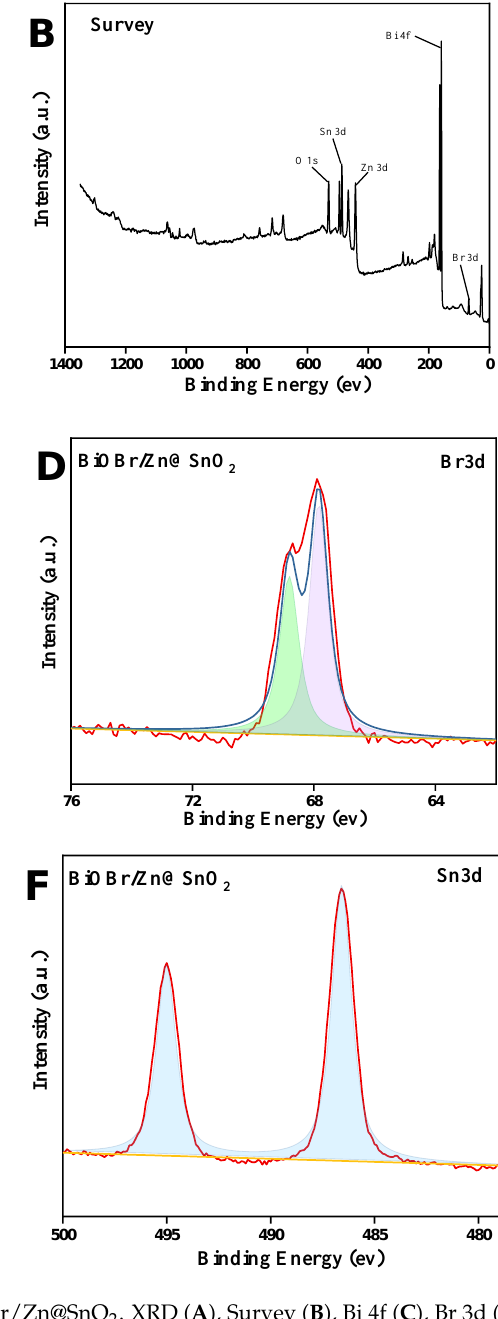
Figure 3. XRD and XPS images of BiOBr/Zn@SnO 2 . XRD ( A ), Survey ( B ), Bi 4f ( C ), Br 3d ( D ), Zn 3d ( E ), Sn 3d ( F ). ( E ), Sn 3d ( F